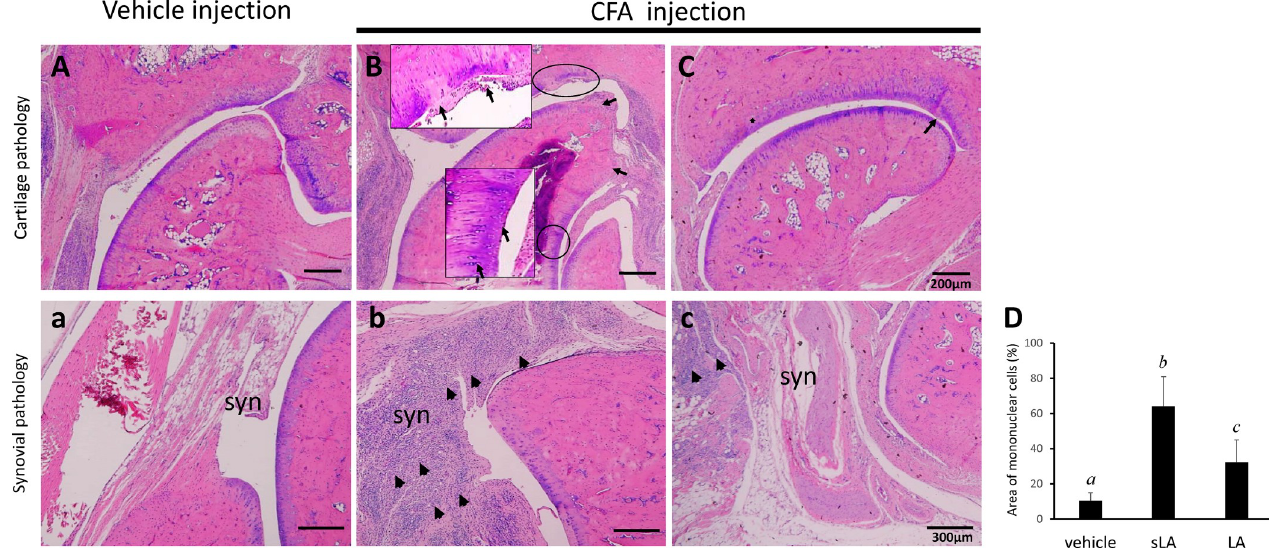
Fig 3. Representative HE sections of the hind paws obtained from vehicle (A) and CFA-induced arthritic animals treated with sham-operated and laser acupuncture (sLA and LA, B and C). Histology showed articular cartilage changes (A-C) and synovial (syn) inflammation (a-c) in the CFA-injected side of sLA and LA groups when compared to the vehicle side. The articular cartilage surface was smooth and evenly stained on the vehicle control side of each group, but there were apparent articular cartilage fissures, extending from the surface to the depth with significant loss of staining in the sLA group. Synovium showed thickening and widening of the synovial membrane and infiltration of inflammatory cells being less in rats from the LA groups (c) and apparent in rats of sLA group (b). The bar graph shows a statistical difference in the area of infiltrating inflammatory cells among the ankles treated with vehicle, sLA, and LA (D). Each value represents the mean ± SD. Values in each bar with different italic letters ( a , b , c )indicate significant difference at confidence level of P < 0.05 tested by the Scheffe´ post hoc test. The arrows indicate areas of cartilage disruption and chondrocyte disorientation with clusters of chondrocytes. The arrowheads indicate areas of inflammatory cell infiltration in